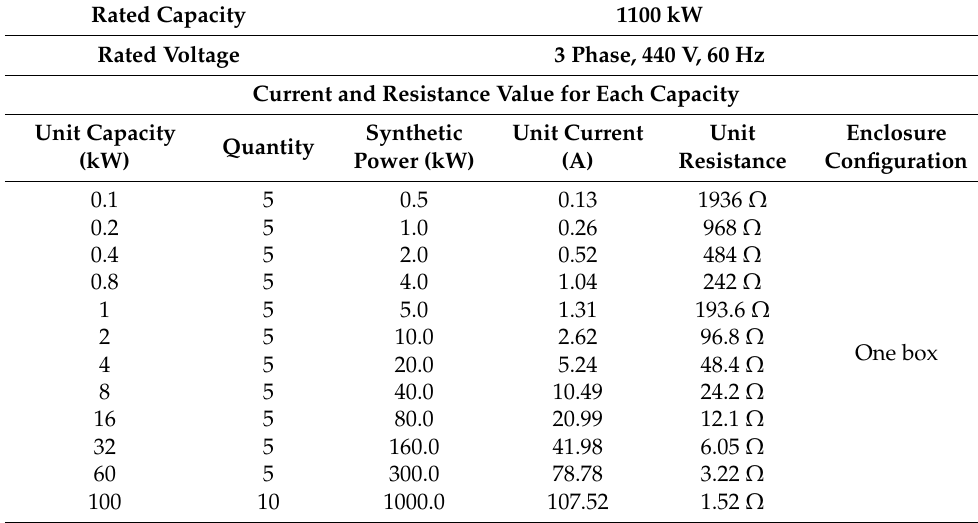
Table 4. Load bank specifications of the